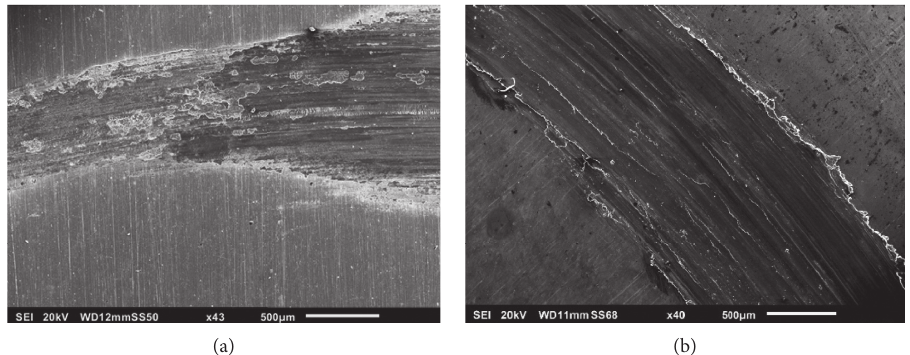
Figure 4: Photograph of SEM wear track: (a) thin film deposited specimen (15 ∗ ); (b) specimen without thin films (4 ∗